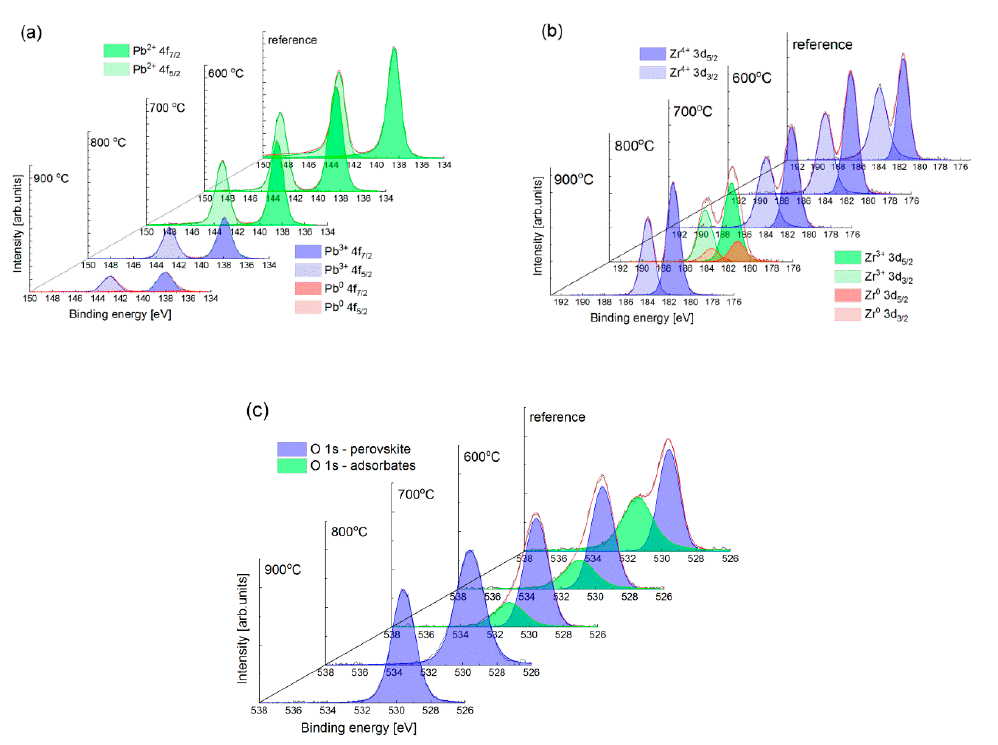
Figure 3. Core electron states of ( a ) lead 4f, ( b ) zirconium 3d, and ( c ) oxygen 1s for a virgin sample and sample after annealing at 600, 700, 800 and 900 °C [31].